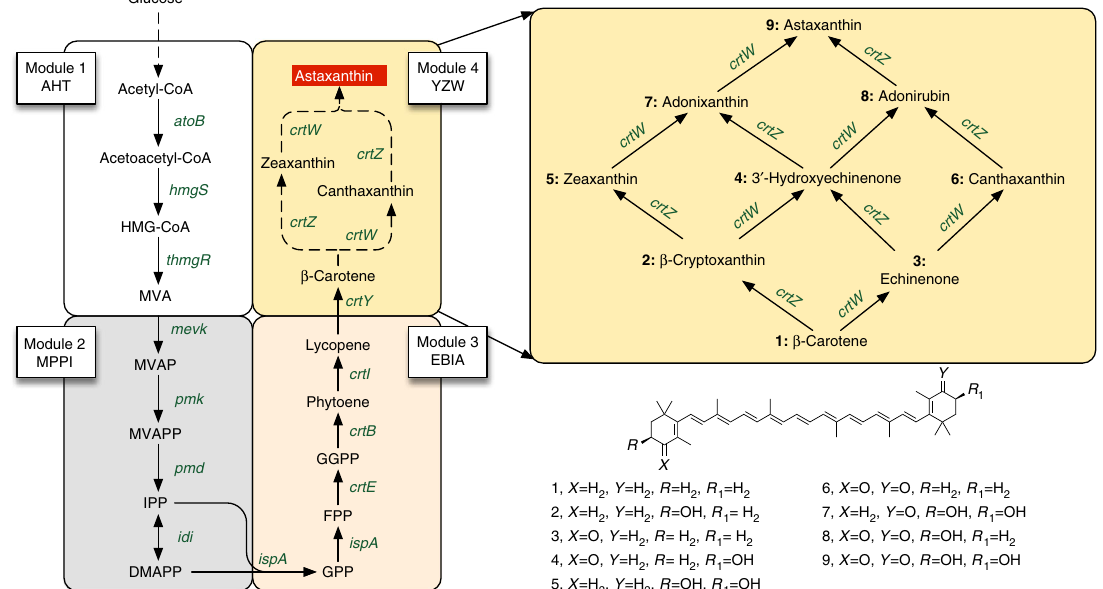
Fig. 1 Biosynthetic pathway of astaxanthin. The biosynthetic pathway was grouped into four major modules: the upstream MVA pathway (module 1 or AHT, including atoB , hmgS, and thmgR ), the downstream MVA pathway (module 2 or MPPI, including mevk , pmk , pmd , and idi ), the lycopene pathway (module 3 or EBIA, including crtEBI and ispA ) and the astaxanthin pathway (module 4 or YZW, including crtYZW ). Abbreviation for the compounds: HMG- CoA, 3-hydroxy-3-methyl-glutaryl-coenzyme A; MVA, mevalonate; MVAP, phosphomevalonate; MVAPP, diphosphomevalonate; IPP, isopentenyl pyrophosphate; DMAPP, dimethylallyl pyrophosphate; GPP, geranyl pyrophosphate; FPP, farnesyl pyrophosphate; GGPP, geranylgeranyl pyrophosphate. Dashed arrow indicates multiple enzymatic steps. The genes expressed encode the following enzymes: atoB , acetoacetyl-CoA thiolase; hmgS , HMG-CoA synthase; thmgR , truncated HMG-CoA reductase; mevk , mevalonate kinase; pmk , phosphomevalonate kinase; pmd , mevalonate pyrophosphate decarboxylase; idi , IPP isomerase; ispA , FPP synthase; crtE , GGPP synthase; crtB , phytoene synthase; crtI , phytoene desaturase; crtY , lycopene cyclase; crtW , β -carotene ketolase; crtZ , β -carotene